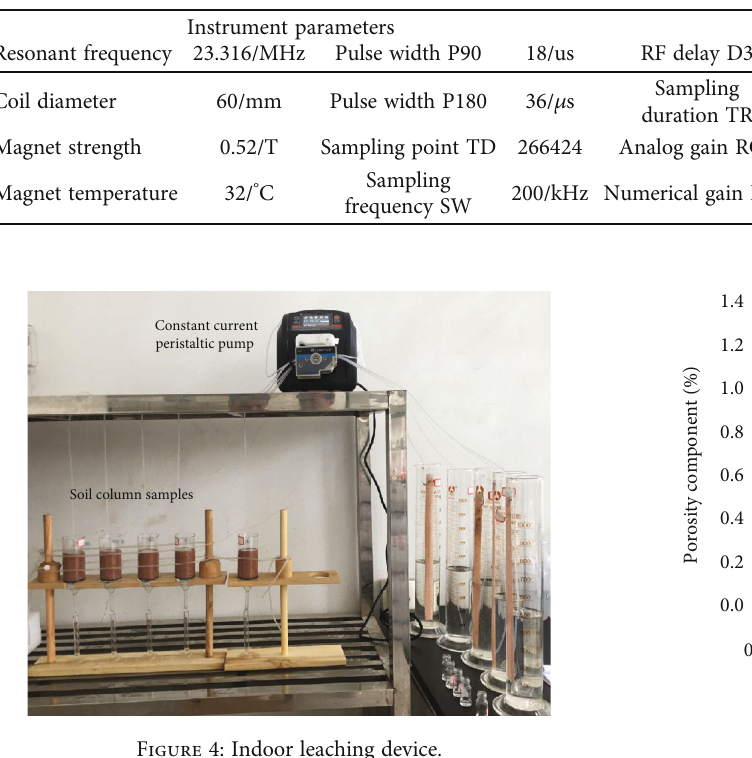
Table 4: Technical parameters and test parameters of low fi eld NMR.